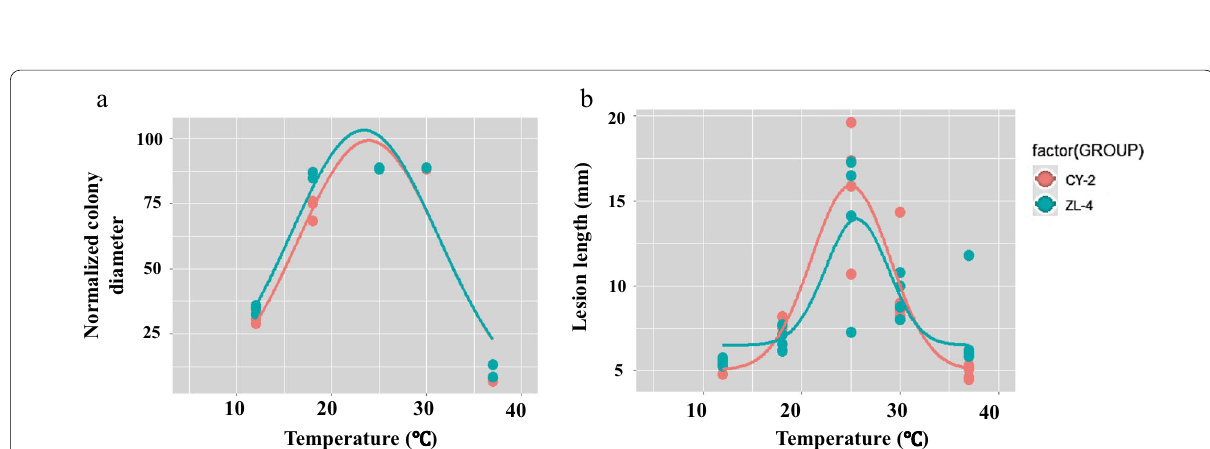
Fig. 5 The optimal temperature for growth and infection. a Optimum temperature for growth. Fungal plugs of CY-2 and ZL-4 isolates were inoculated on PDA plates and incubated at different temperatures as indicated. Colony diameters were measured at 2 dpi. The column graph was formatted using the GraphPad prism software based on the lesion length. b The optimum temperature for infection on pear. Fungal plugs of both isolates were used to inoculate the pathogens onto pear branches and incubated under different temperatures. Two days later, the lesion length was measured, and photos were collected. The column graph was formatted using the GraphPad prism software based on the lesion length. Each treatment replicates three times, and data were analyzed using ANOVA. ** P <